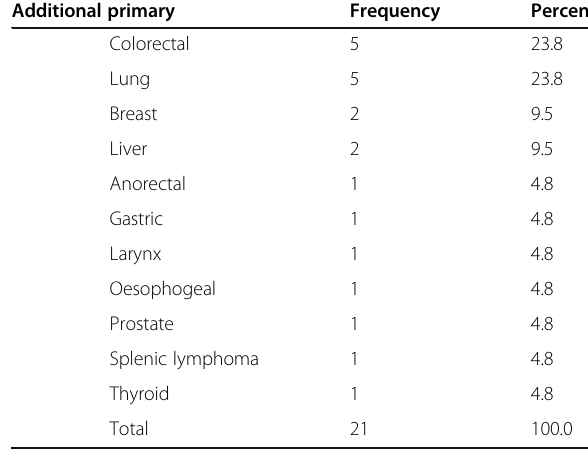
Analysis of PET/CT findings True-positive lesion The malignancy diagnosed from PET/CT scan in accordance with that from the pathologic results. True-negative lesion The malignancy was excluded from PET/CT scan in accordance with that from the pathologic results. False-positive lesion The malignancy diagnosed from PET/CT scan discord- ance with that from the pathologic results (not neoplas- tic or metastasis of the primary). Table 3 Summary of index tumor in the studied patients Primary index Table 4 Summary of the additional primary in the studied